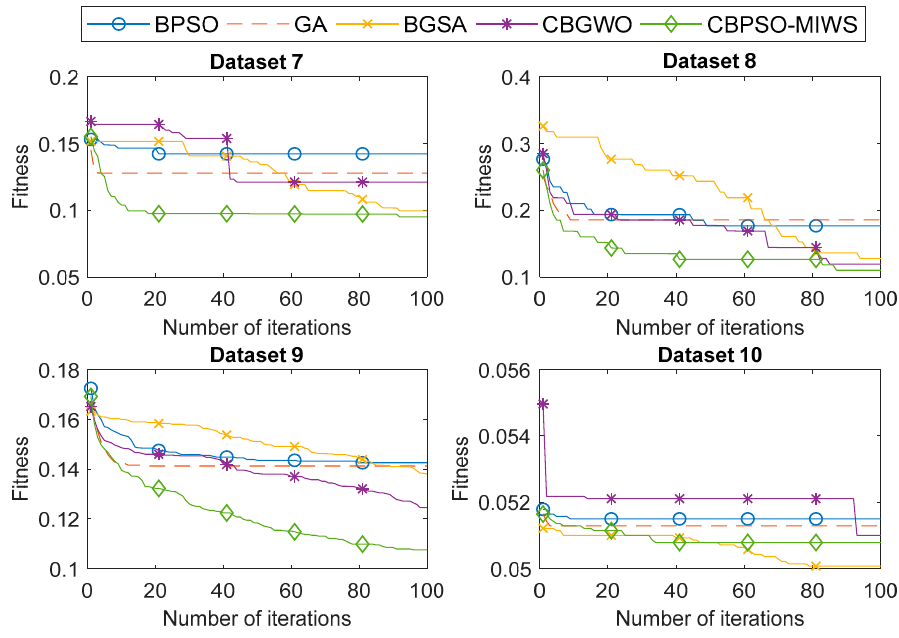
Figure 4. Convergence curves of five feature selection methods on datasets 1 to 6. Informatics 2019 , 6 , x